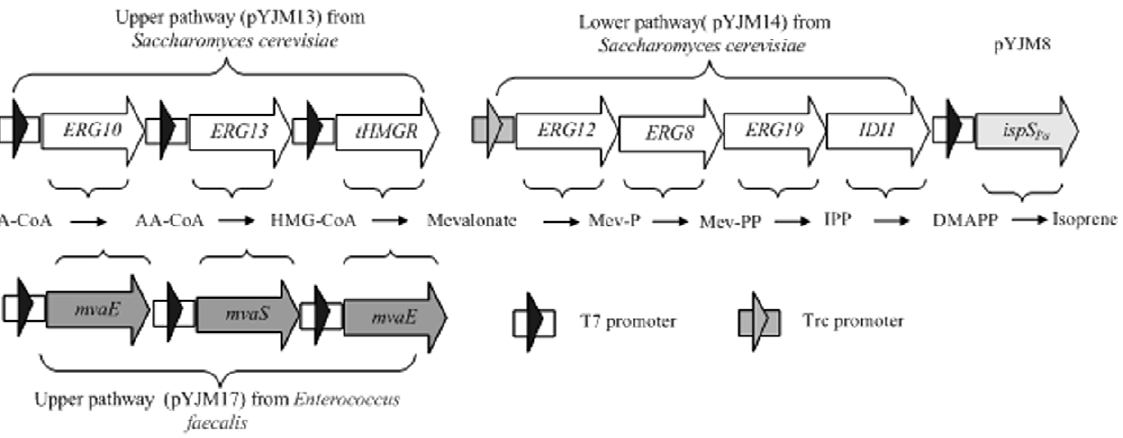
Figure 1. Production of isoprene via the MVA pathways used in this study. Gene symbols and the enzymes they encode (all genes marked with white arrows were isolated from S. cerevisiae , the gene marked with light gray arrows derived from P. alba and all genes marked with gray arrows were from Enterococcus faecalis ). MVA pathway: ERG10, acetoacetyl-CoA thiolase; ERG13, HMG-CoA synthase; tHMGR, truncated HMG-CoA reductase; MvaE, acetyl-CoA acetyltransferase/HMG-CoA reductase; MvaS, HMG-CoA synthase; ERG12, mevalonate kinase; ERG8, phosphomevalonate kinase; ERG19, mevalonate pyrophosphate decarboxylase; IDI1, IPP isomerase; ispSPa, P. alba isoprene synthase was optimized to the preferred codon usage of E. coli . Pathway intermediates. MVA pathway: A-CoA, acetyl-CoA; AA-CoA, acetoacetyl-CoA; HMG-CoA, hydroxymethylglutaryl-CoA; Mev-P, mevalonate 5-phosphate; Mev-PP, mevalonate pyrophosphate. IPP, isopentenyl pyrophosphate; DMAPP, dimethylallyl pyrophosphate.